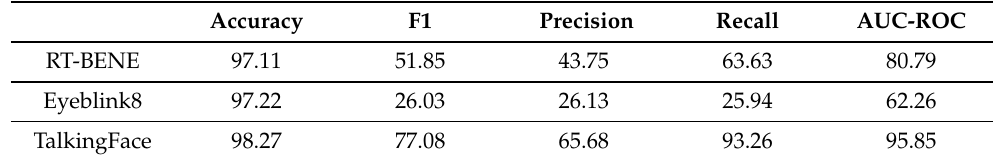
Table 4. Results for EAR with adaptive